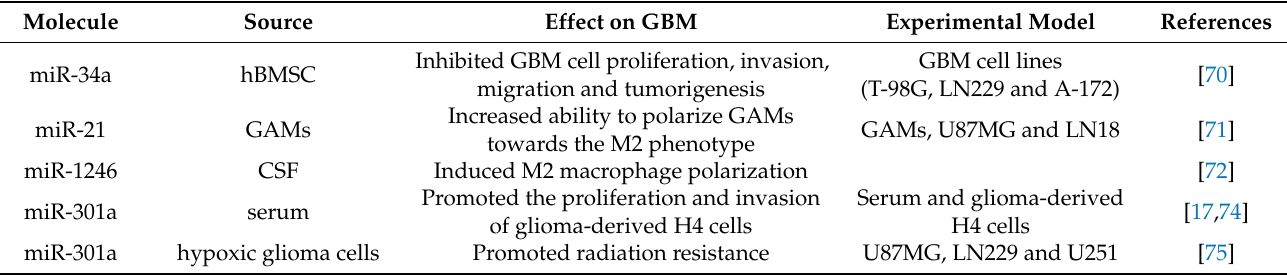
Table 1. Tumorigenesis in EVs’ microRNAs with a role in glioblastoma